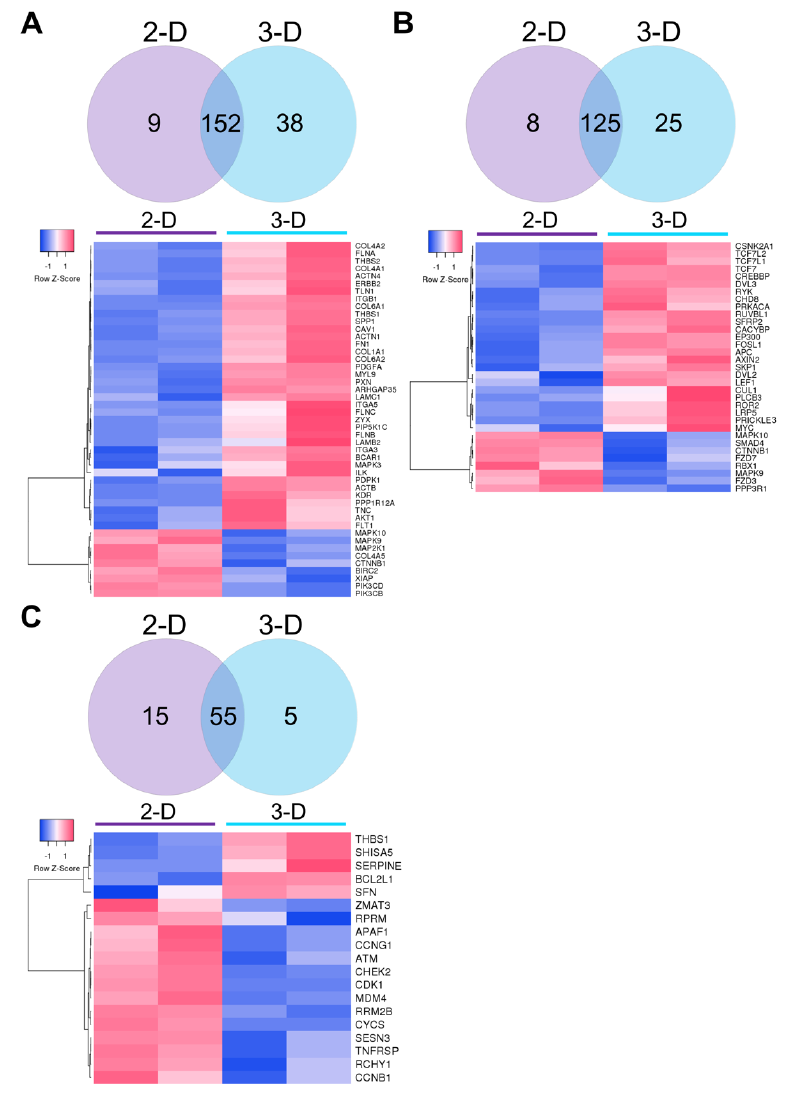
Figure 6. Heatmaps showing raw z-scores of RNA-seq log2 transformed values of 2-D and 3-D grown naïve ESCs. Venn diagrams show the number of genes upregulated in 2-D, genes not significantly changed between 2-D and 3-D, and genes upregulated in Elf1 cells during growth in 3-D scaffolds. Up- and downregulated genes are red and blue, respectively, at a cutoff of p < 0.05. Heatmaps depicting significantly DEGs associated with the ( A ) focal adhesion pathway, ( B ) Wnt pathway, and ( C ) p53 pathway were determined using Kyoto Encyclopedia of Genes and Genomes (KEGG)